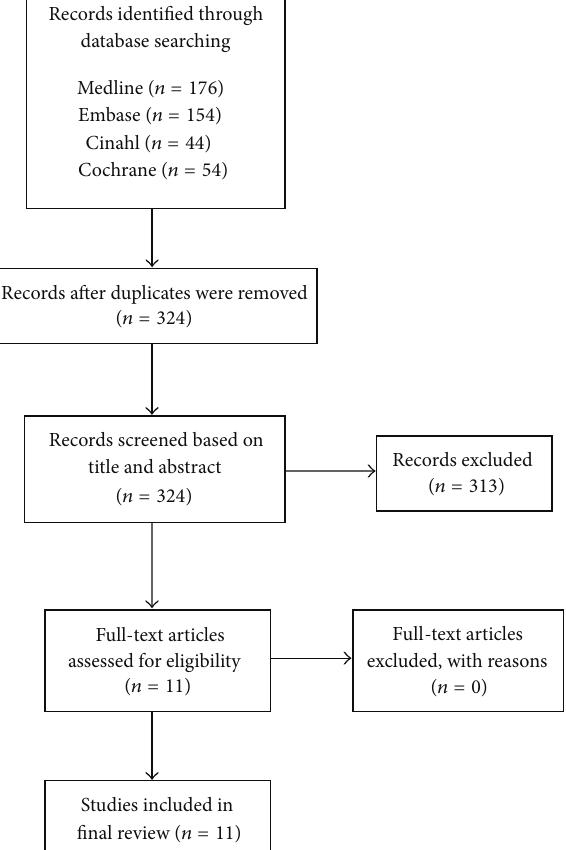
Figure 1: Flow diagram of study selection